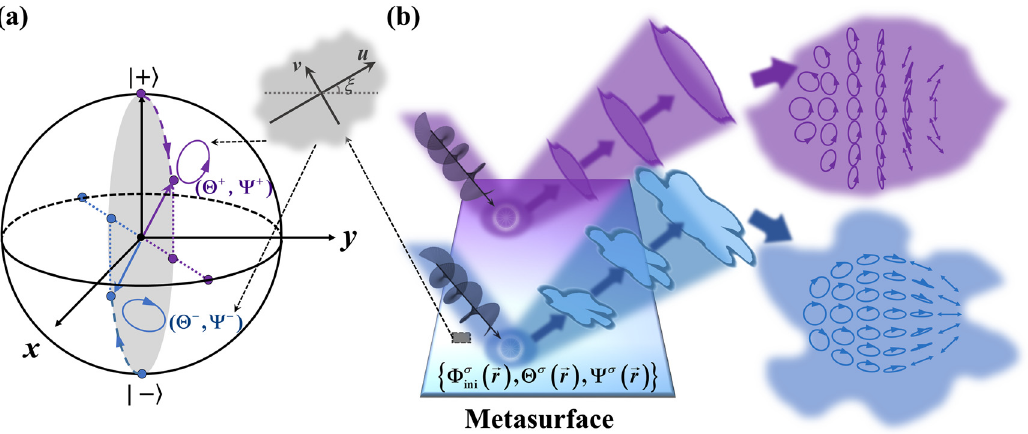
Figure 1: Schematics of spin-delinked bifunctional vectorial optical field (VOF) generations. (a) Dashed lines in blue and purple colors illustrate how the polarization change from initial left circular polarization (LCP) and right circular polarization (RCP) states to two final states denoted by two points ( Θ + , Ψ + ) and ( Θ − , Ψ − ) on Poincare ’ s sphere, as our meta-atom is shined by incident CP light with different helicity. Inset to (a) illustrates the local coordinate of a meta-atom. (b) Schematics of light scatterings at a metasurface exhibiting pre-designed distributions of { Φ σ re fl ected beams with different wave fronts and inhomogeneous polarization